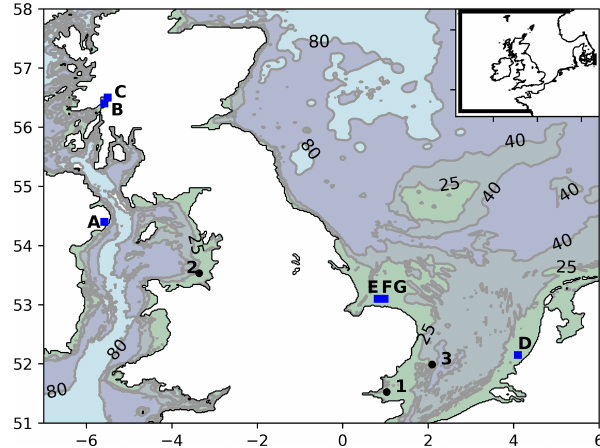
Figure 1. Study area with SmartBuoy stations (black circles: 1 is Warp Anchorage, 2 is Liverpool Bay, 3 is west Gabbard; www. cefas.co.uk/cefas-data-hub/smartbuoys) and macroalgae farm loca- tions (blue squares represent the macroalgae farms: A is Strang- ford Lough; B is Sound of Kerrera; C is Lynn of Lorne; D is Rhine plume; E–G are north Norfolk; see Table 4 for more information). Depths are in metres. Inset: North-west European Shelf seas with model domain boundaries (thick black